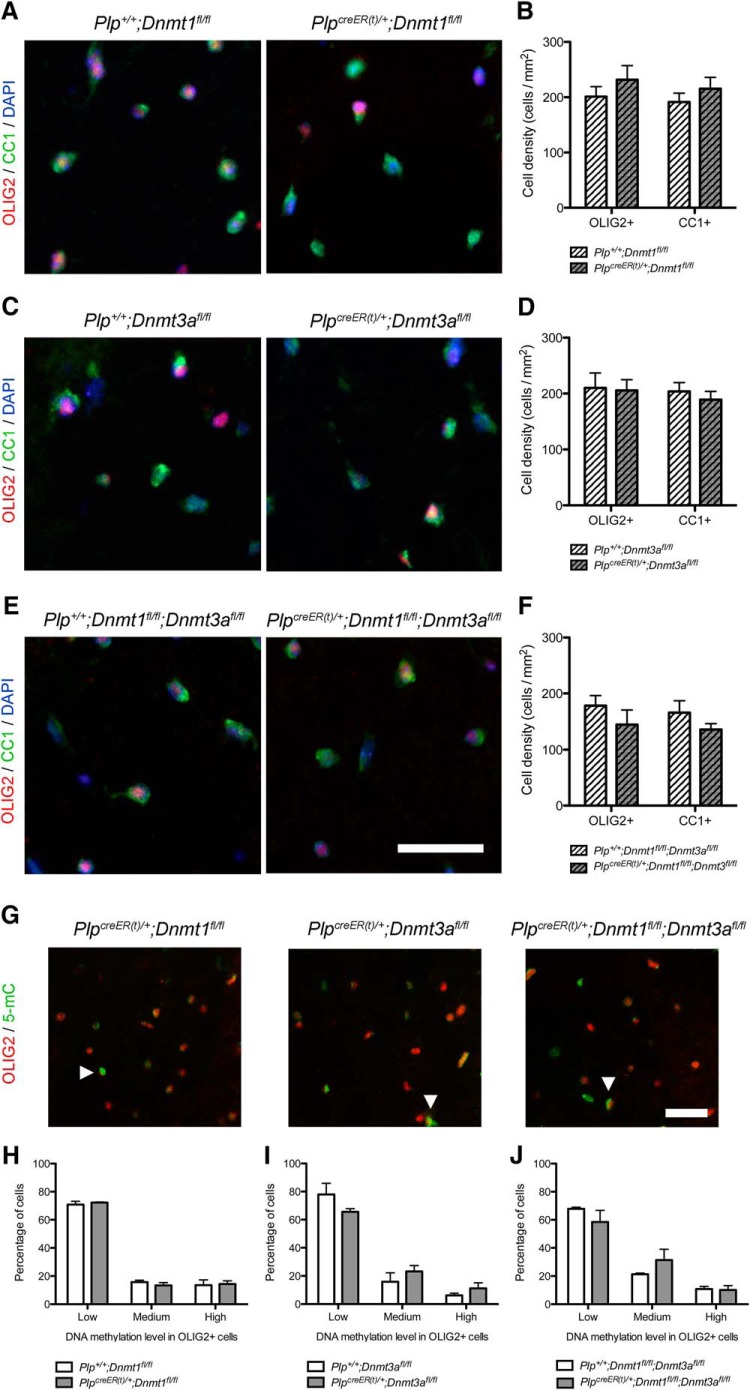
Ablation of Dnmt1 or Dnmt3a does not impair oligodendrocyte differentiation or their methylation levels in control conditions. A, Representative OLIG2 and CC1 staining in tamoxifen-treated Plp+
/+;Dnmt1fl/fl and PlpcreER(t)
/+;Dnmt1fl/fl NWM spinal cords. B, Quantification of OLIG2+ and CC1+ cell densities in NWMf (p = 0.3537, p = 0.3803). C, Representative OLIG2 and CC1 staining in tamoxifen-treated Plp+
/+;Dnmt3afl/fl and PlpcreER(t)
/+;Dnmt3afl/fl NWM spinal cords. D, Quantification of OLIG2+ and CC1+ cell densities in NWMg (p = 0.8926, p = 0.5109). E, Representative OLIG2 and CC1 staining in tamoxifen-treated Plp+
/+;Dnmt1fl/fl;Dnmt3afl/fl and PlpcreER(t)
/+;Dnmt1fl/fl;Dnmt3afl/fl NWM spinal cords. F, Quantification of OLIG2+ and CC1+ cell densities in NWMh (p = 0.3136, p = 0.2173). G, Representative 5mC and OLIG2 stainings in tamoxifen-treated PlpcreER(t)
/+;Dnmt1fl/fl, PlpcreER(t)
/+;Dnmt3afl/fl, and PlpcreER(t)
/+;Dnmt1fl/fl;Dnmt3afl/fl NWM spinal cords (white arrowheads indicate high-5mC+/OLIG2+ cells). H, Quantification of low-, medium-, and high-5mC levels in OLIG2+ cells in tamoxifen-treated Plp+
/+;Dnmt1fl/fl and PlpcreER(t)
/+;Dnmt1fl/fl NWMj. I, Quantification of low-, medium-, and high-5mC levels in OLIG2+ cells in tamoxifen-treated Plp+
/+;Dnmt3afl/fl and PlpcreER(t)
/+;Dnmt3afl/fl NWMjj. J, Quantification of low-, medium-, and high-5mC levels in OLIG2+ cells in tamoxifen-treated Plp+
/+;Dnmt1fl/fl;Dnmt3afl/fl and PlpcreER(t)
/+;Dnmt1fl/fl;Dnmt3afl/fl NWMk. Scale bar = 50 µm. Data are mean ± SEM. n = 4–6 animals, three sections per animal (Student’s t test, ANOVA).